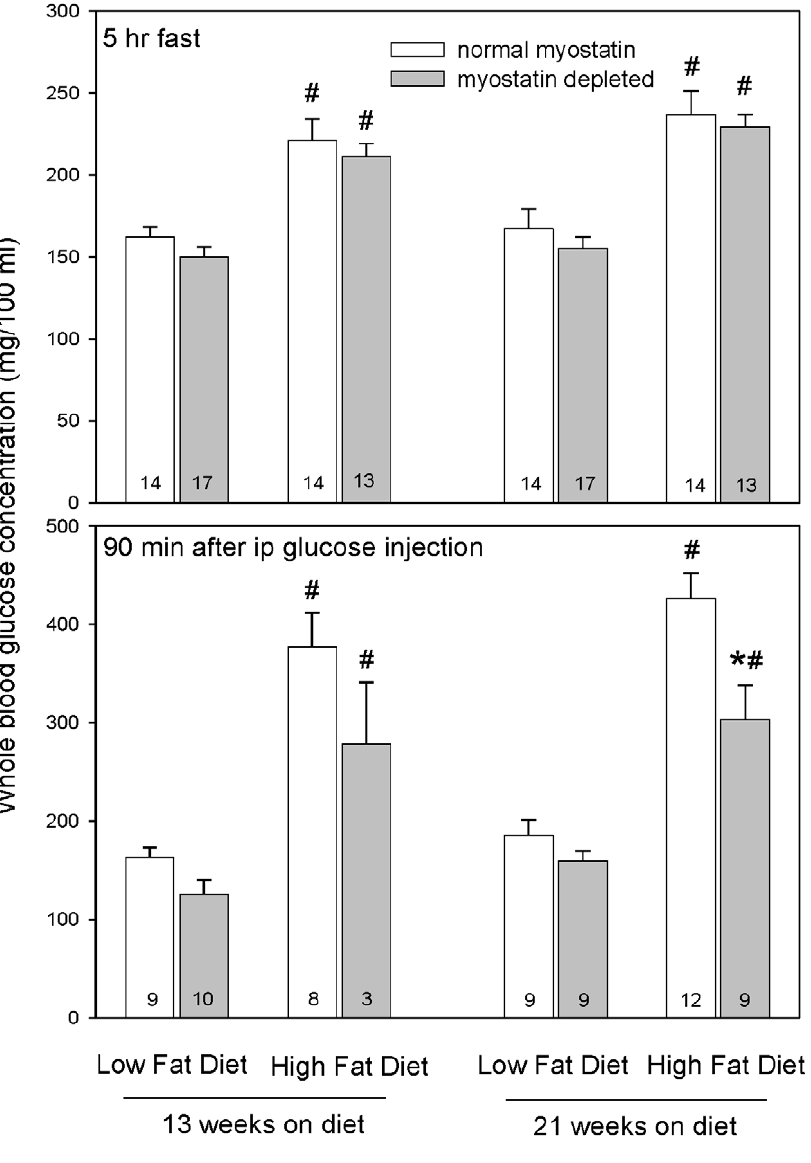
Figure 3. Mean ( + SEM) blood glucose concentrations. Bars represent means, whiskers represent SEM. Number of values included in each mean are shown at the bottom of each bar. * P , 0.01 vs. normal myostatin group represented by adjacent bar. # P , 0.02 vs. low-fat group with same myostatin status.